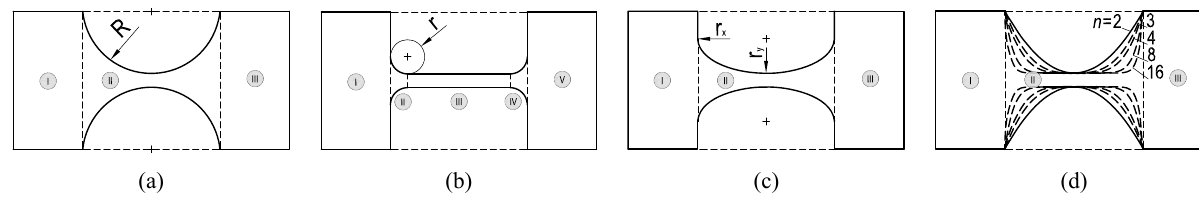
Figure 2. The four implemented flexure hinges with their contour-specific parameters: (a) circular contour with radius R , (b) corner-filleted contour with stress-optimal fillet radius r = 0 . 1 l (Linß et al., 2011b), (c) elliptical contour with major axis r x and minor axis r y , (d) variable power function-based contour (shown for different exponent values n ).